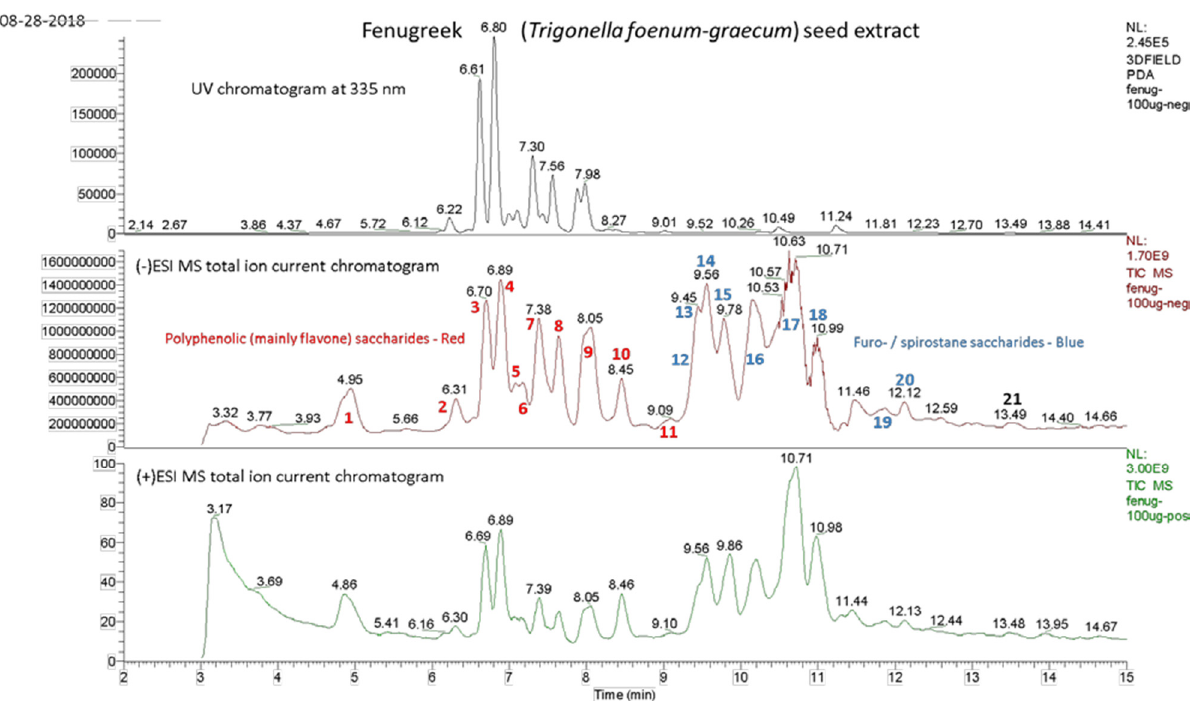
Figure A3. UV Chromatogram fingerprint of fenugreek seed extract at 335 nm ( top panel ) and total ion current LC/MS chromatograms (positive and negative ionization) of fenugreek seed extract ( bottom panels ) by HR-LC-MS. Table A1. Putative identification of peaks corresponding to those labeled in Figure A3 designated by peak number, molecular mass, chemical formula and compound type as determined by HR-LC-MS. Peak